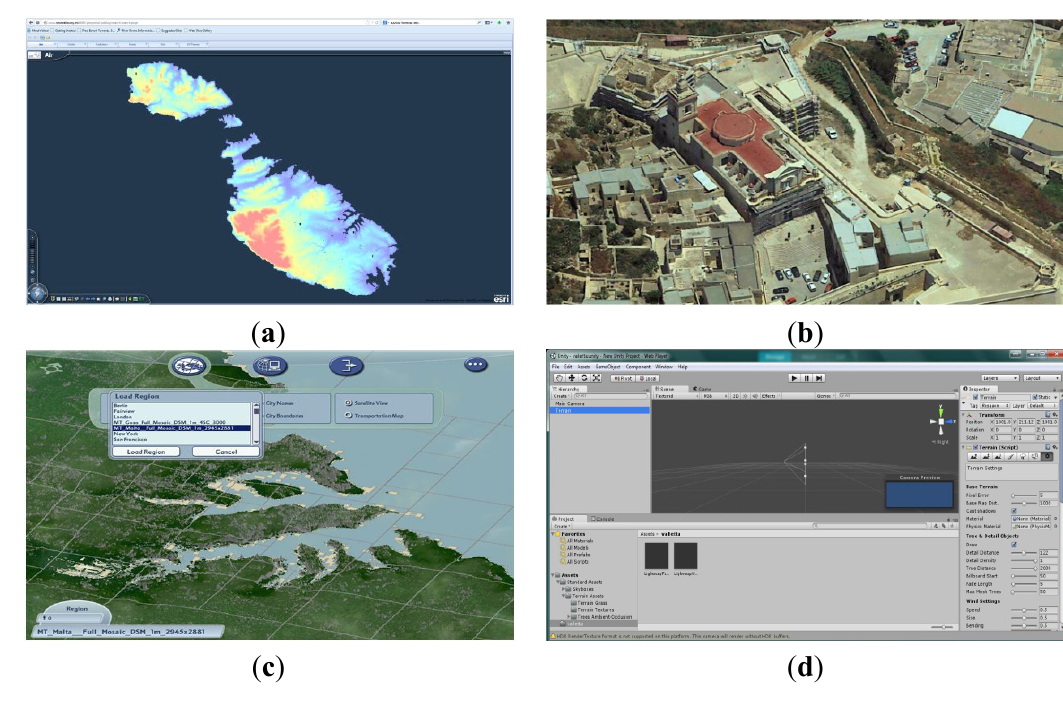
Figure 4. Next steps for the dissemination of the data to professionals and the younger generations ( a ) SEIS interface; ( b ) conversion to the main online servers (GoogleEarth); ( c ) simcity conversion for planners; ( d ) unity for gamers and